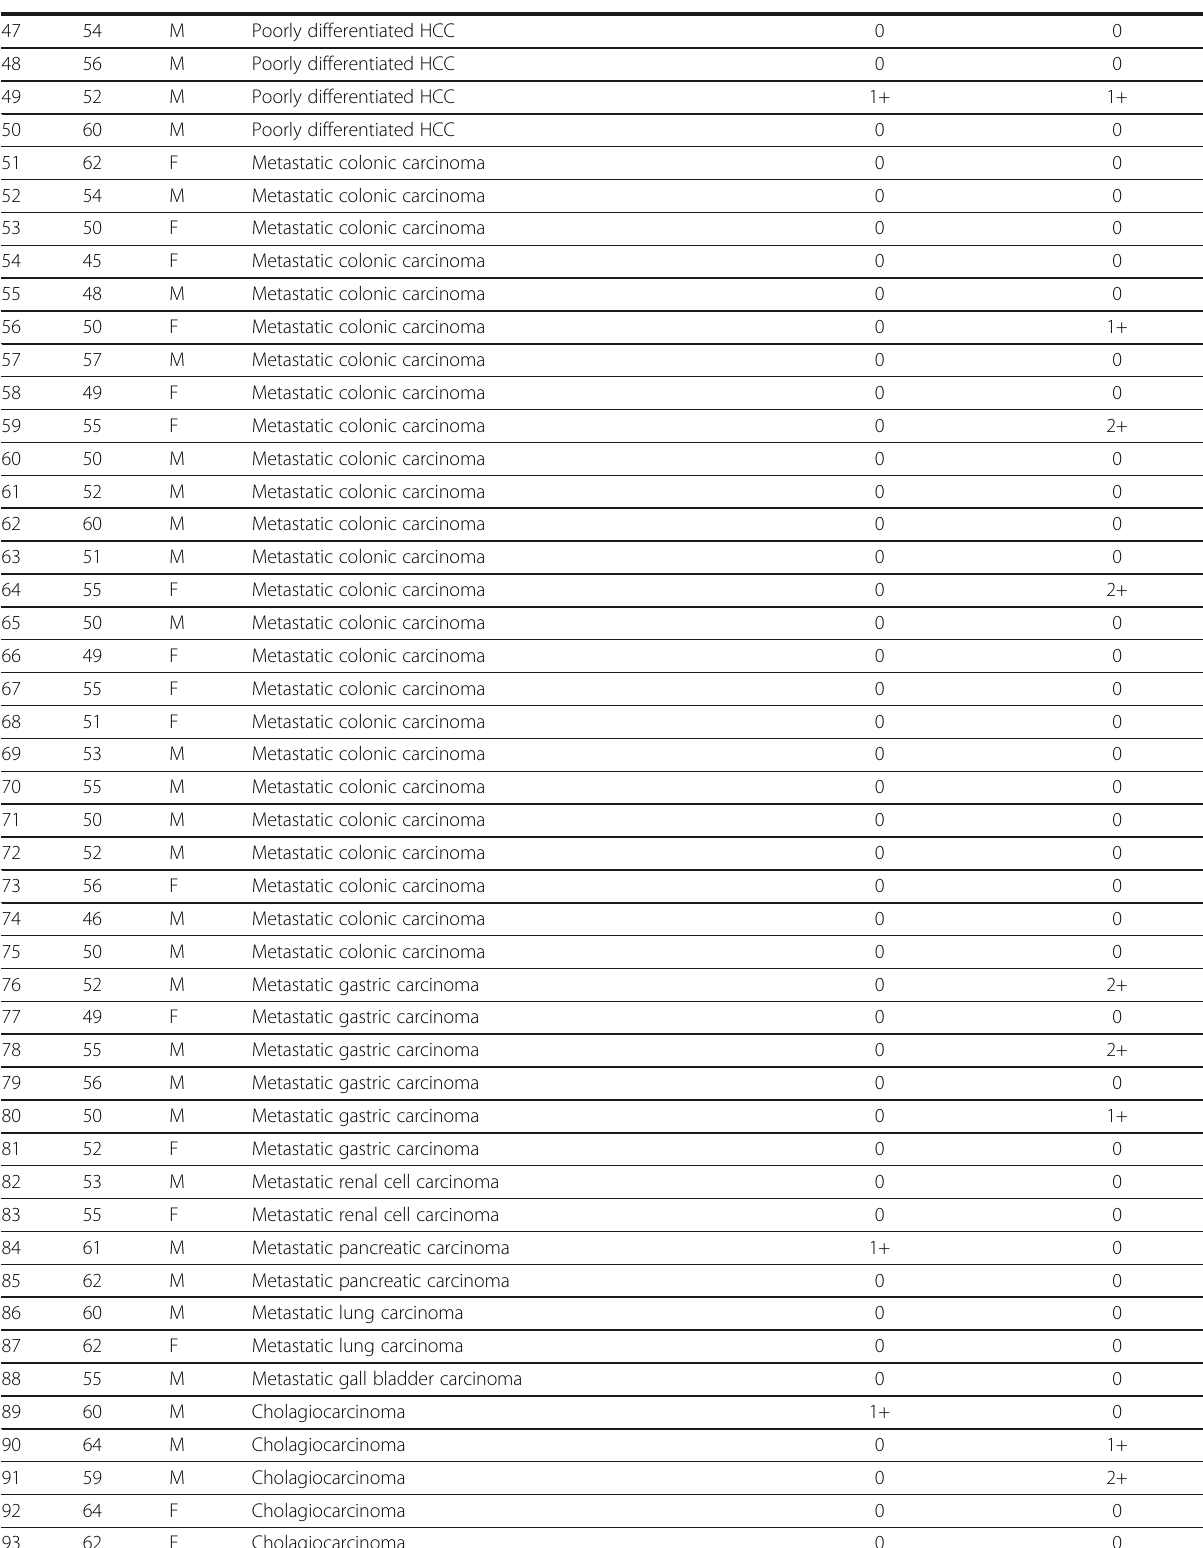
Table 1 Clinicopathological features and the expressions of arginase-1 & HepPar-1 in all studied tumorous cases (no=100)